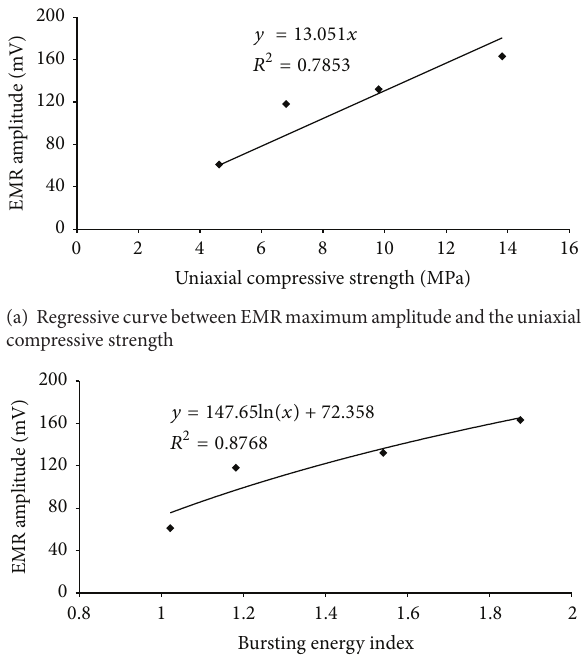
Figure8:CorrelationsbetweenEMRmaximumamplitude,uniaxial compressive strength, and bursting energy index.